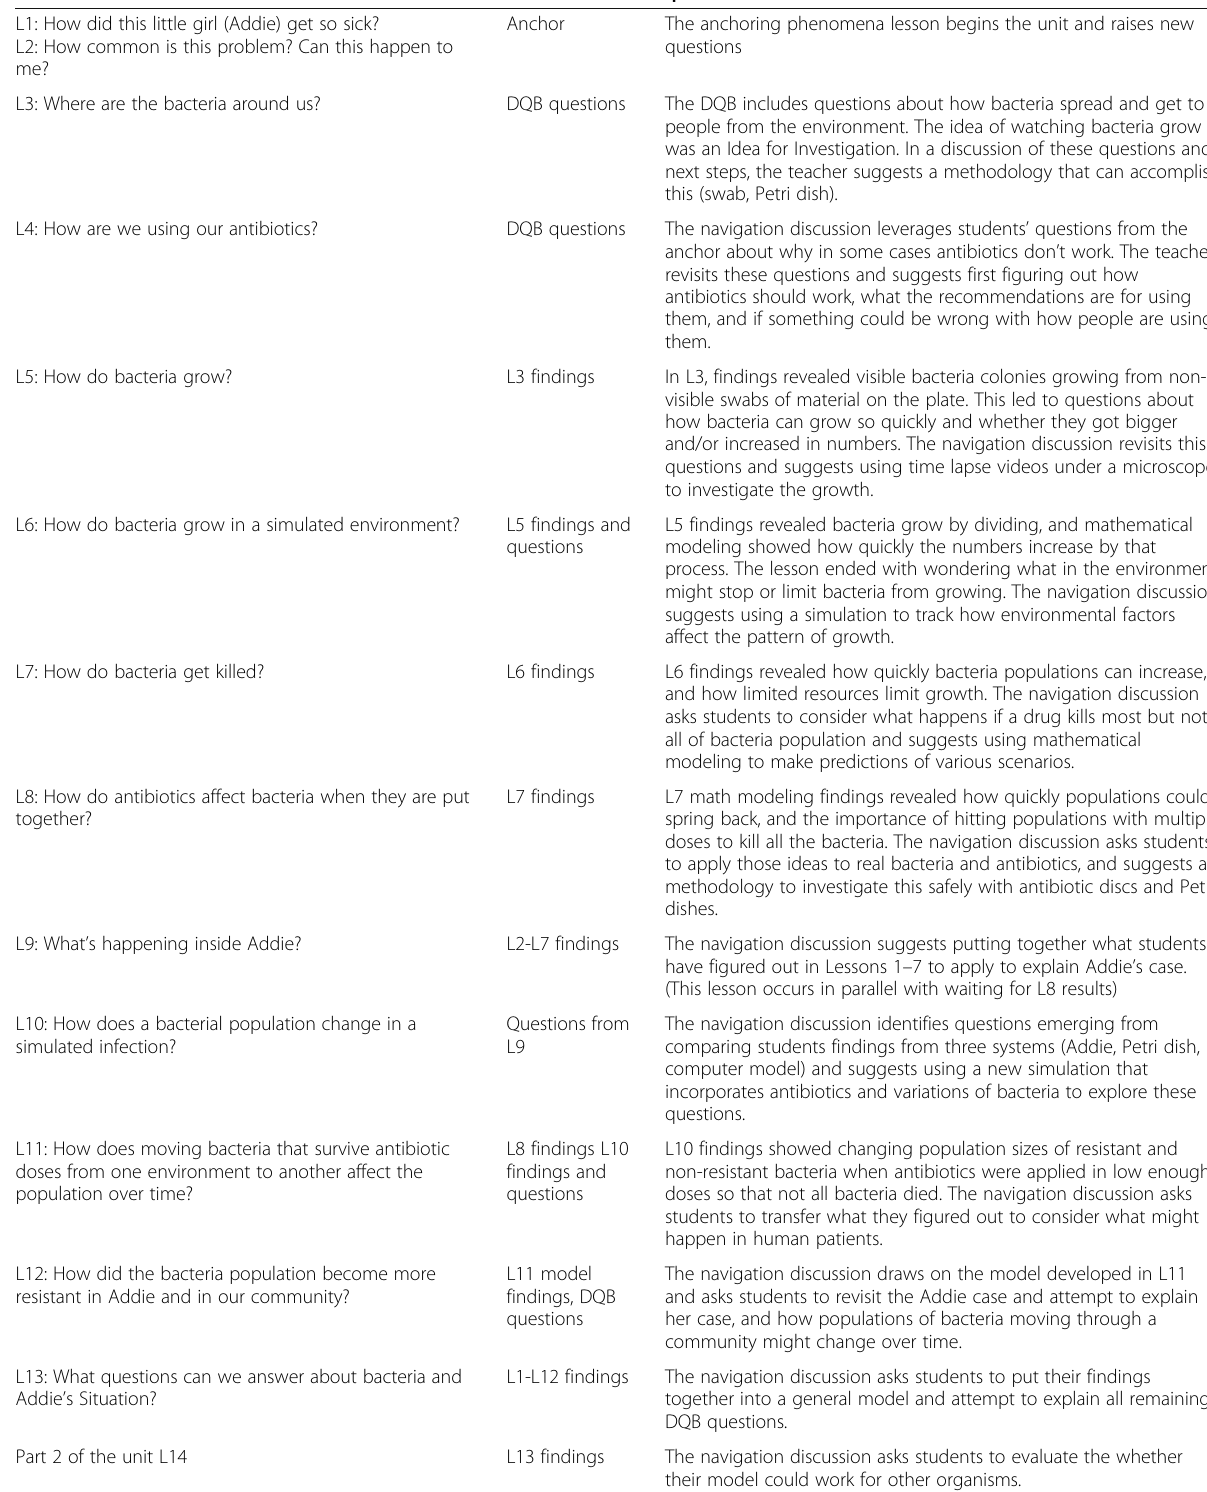
Table 2 Supports in the Storyline for Navigation Discussions Lesson Question from